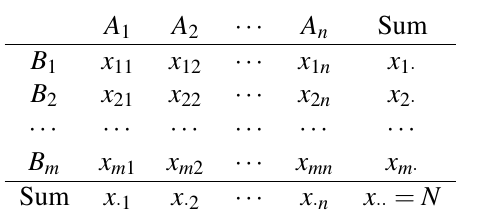
Table 1: Contingency Table ( m × n